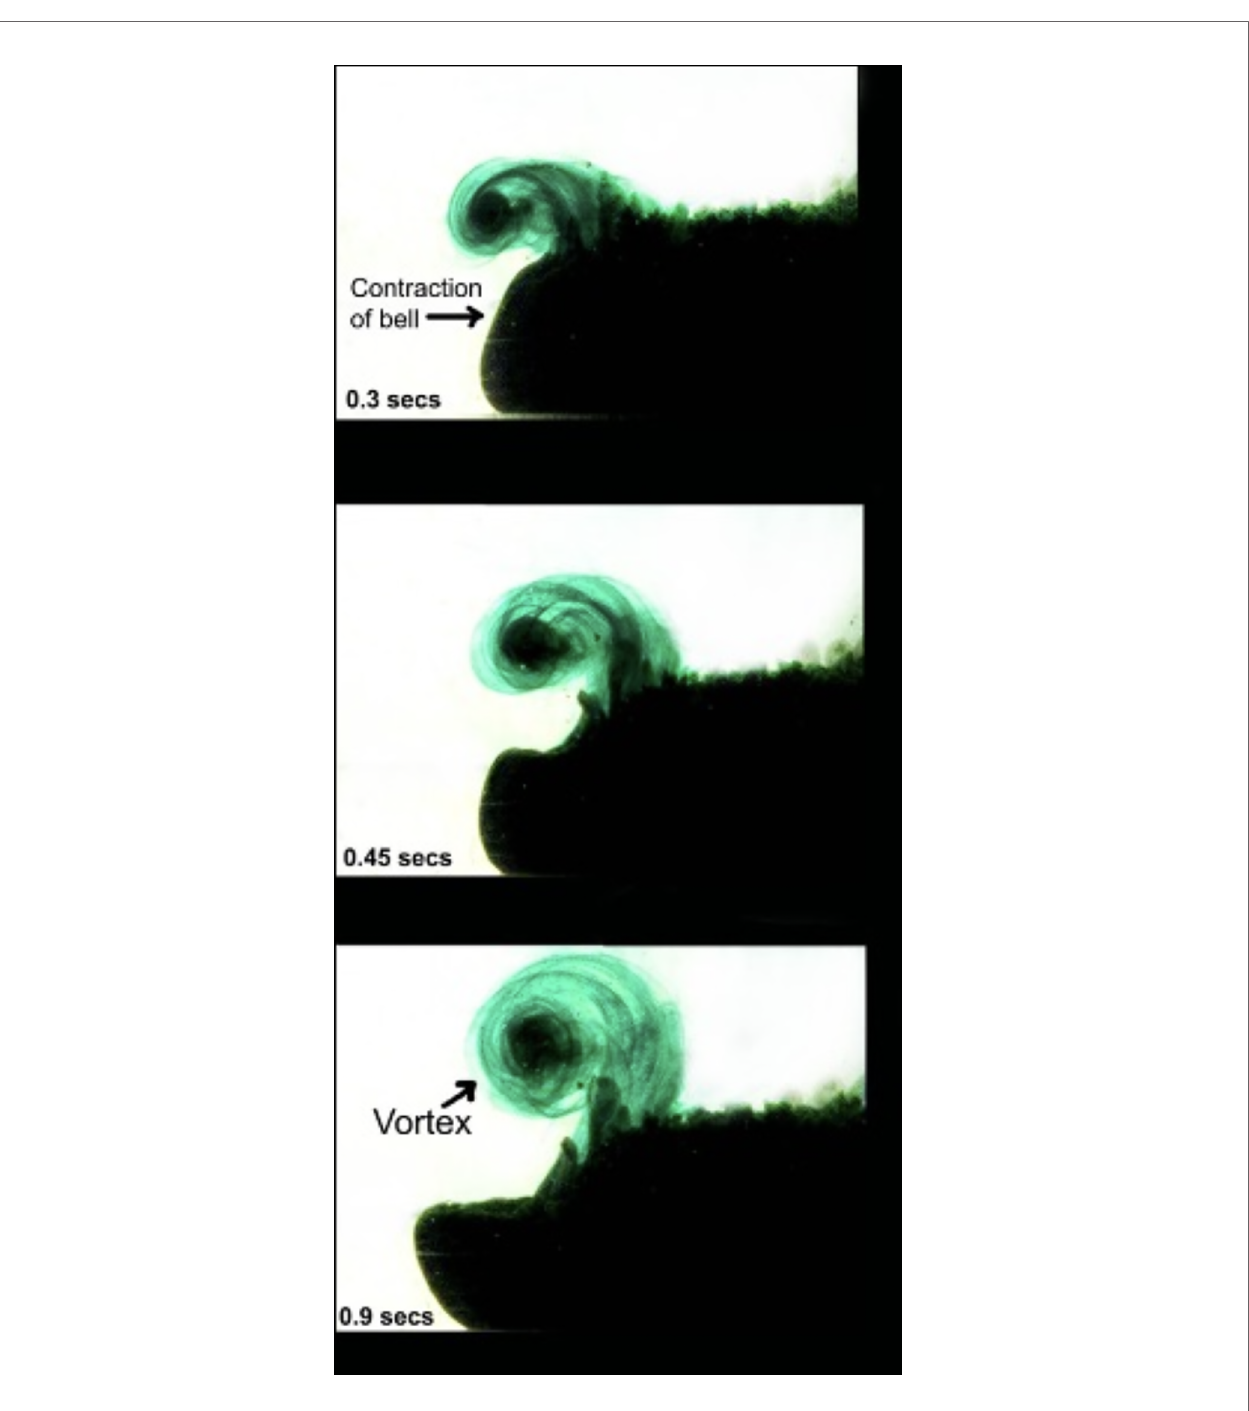
FIGURE 1 | Dye visualization showing the formation and advection of the starting vortex after the jelly fi sh bell contracts. An oppositely spinning stopping vortex forms during the expansion of the bell (not